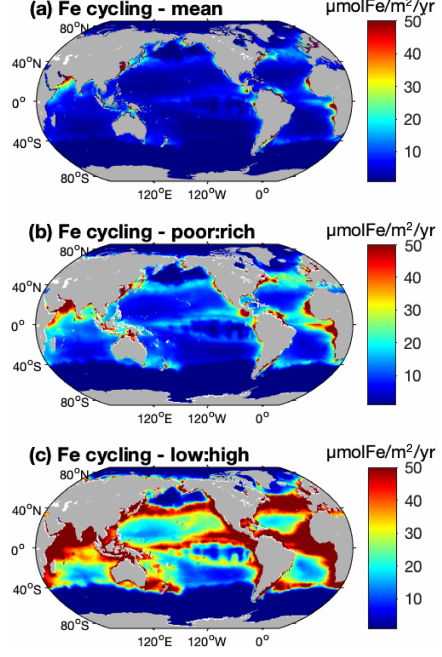
Figure 5. Iron cycling by CTF 100kg biomass computed using (a) a 10g mean Fe:C in zooplankton, (b) a spatial variation between zoo- plankton Fe:C mean values in Fe-poor and Fe-rich areas and based on [NO 3 ] concentrations, and (c) the same spatial variation but us- ing the low and high estimates of zooplankton Fe:C from data. (For more details see